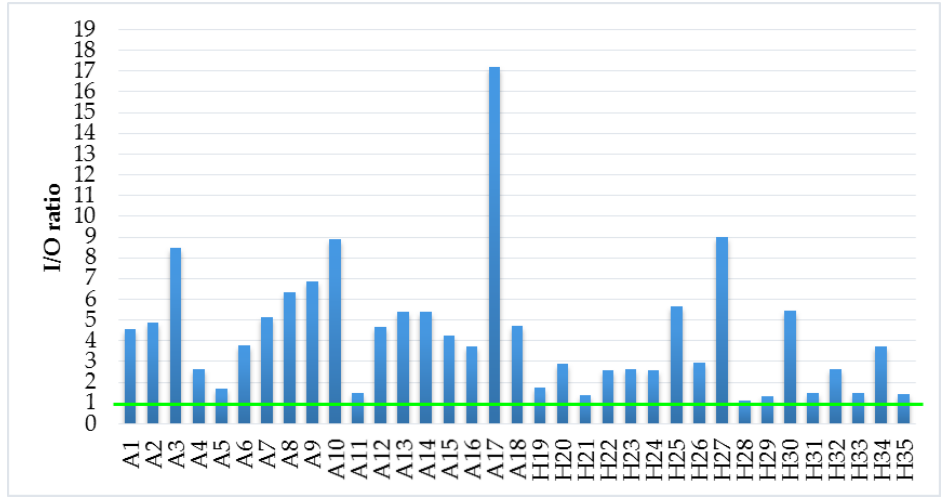
Figure 11. I/O ratio of TVOC levels.